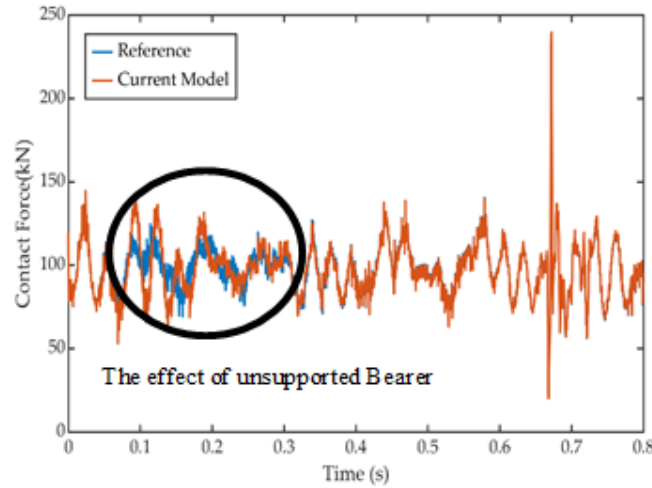
Figure 2. Comparison between the current model and parent model.